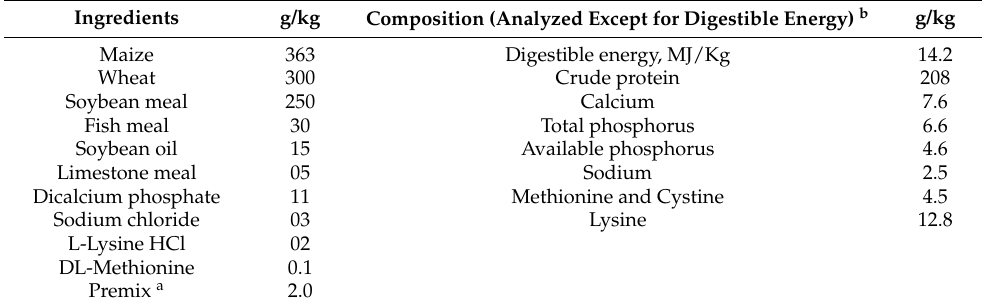
Table 1. Composition and nutrient levels of the basal diet.